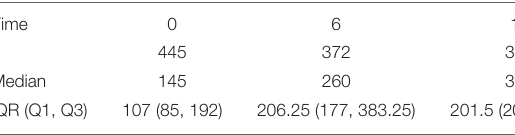
TABLE 2 | Summary of CD4 + cell count at different time points.